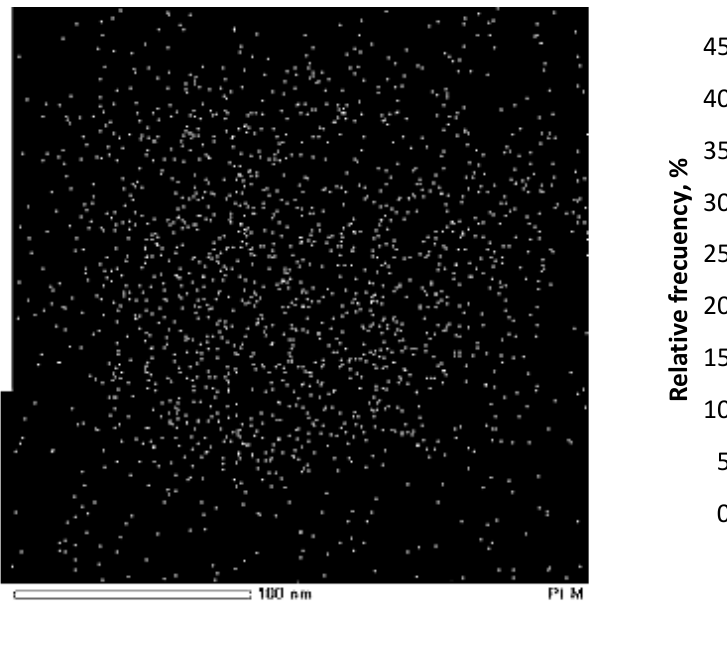
Table 2. The textural properties of parent and Pt- and Co-modified